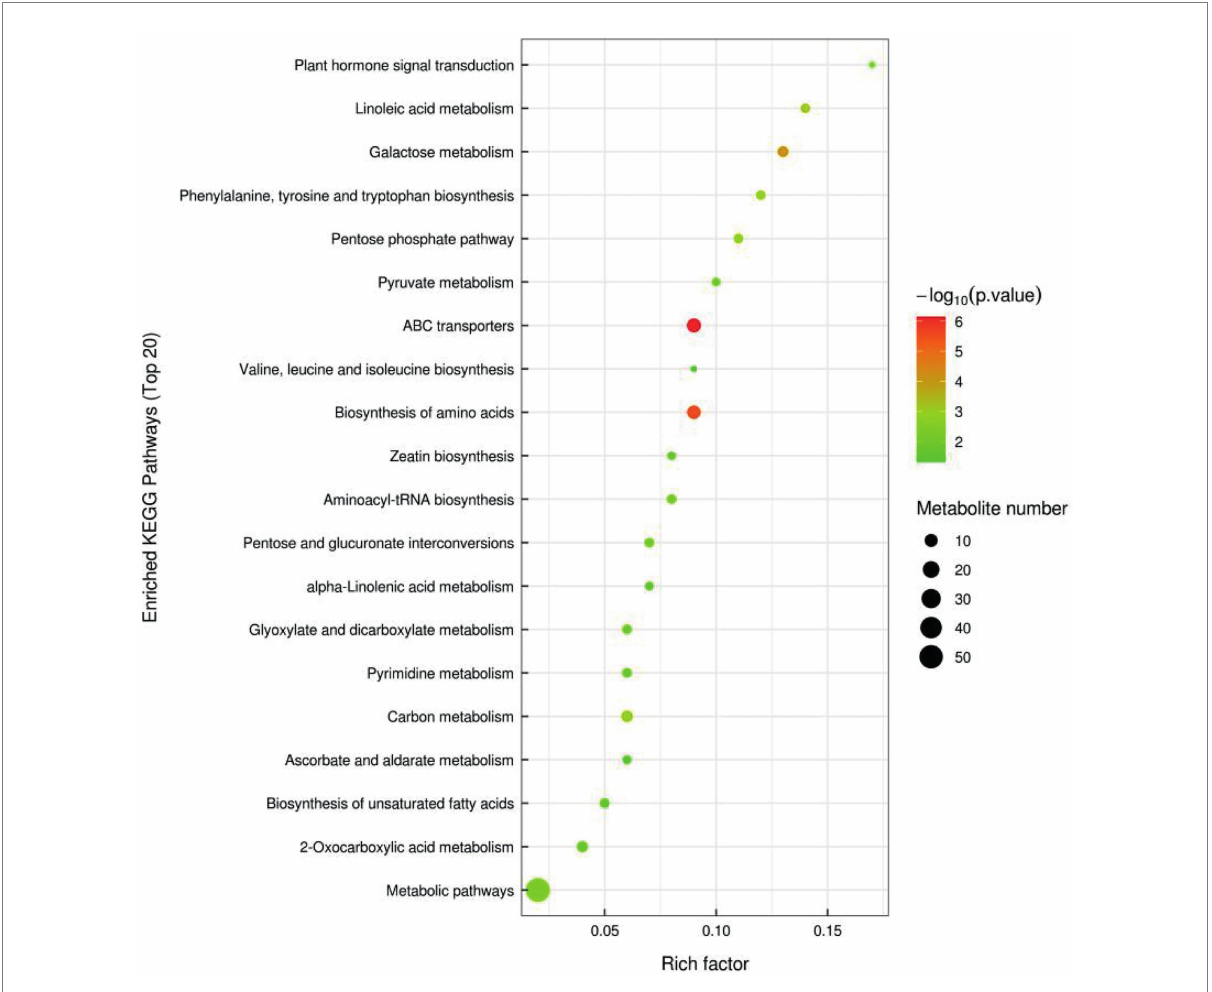
FIGURE 2 Differentially expressed metabolic pathway maps of FGSM and